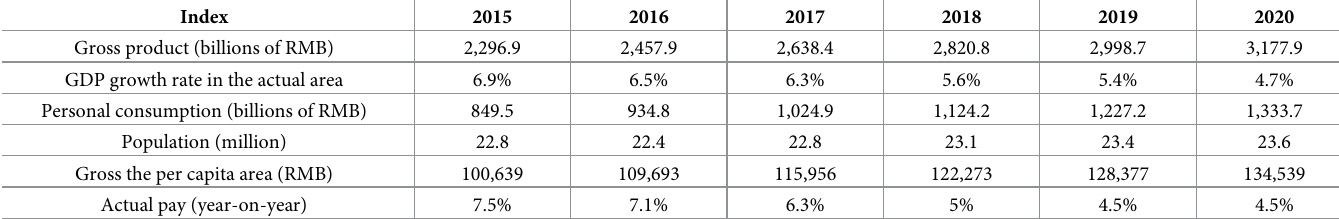
Table 3. Beijing’s social and economic development